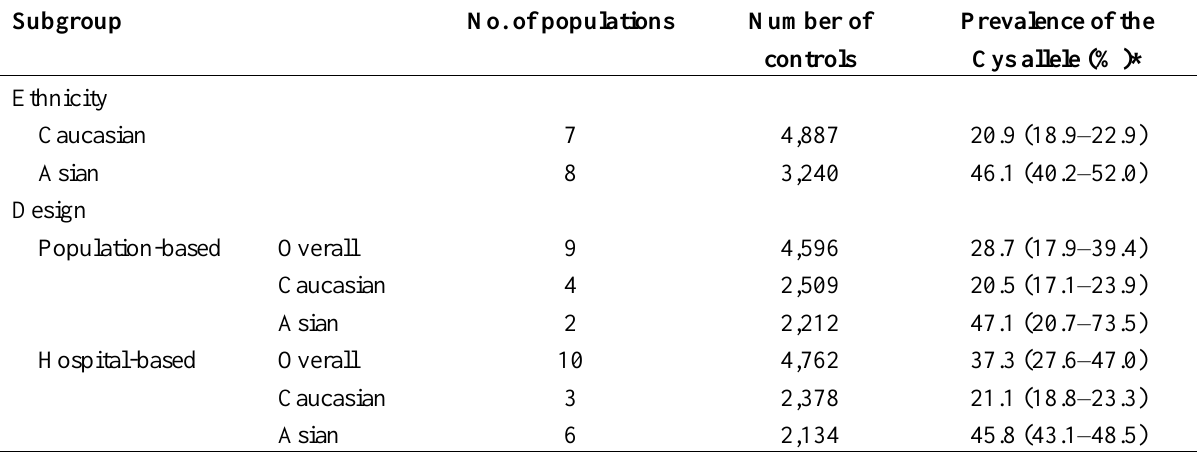
Table 2. The summary prevalence of the Cys allele in